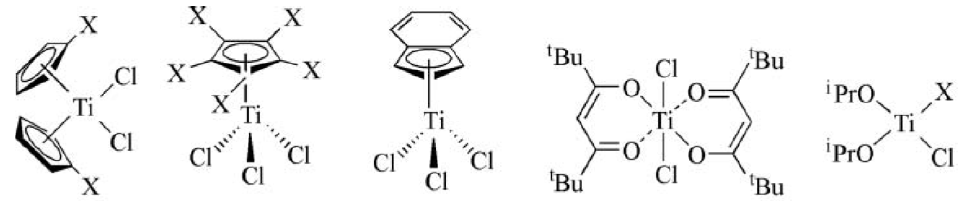
Figure 14. Titanium compounds used as catalysts in radical polymerization using organometallic compounds.